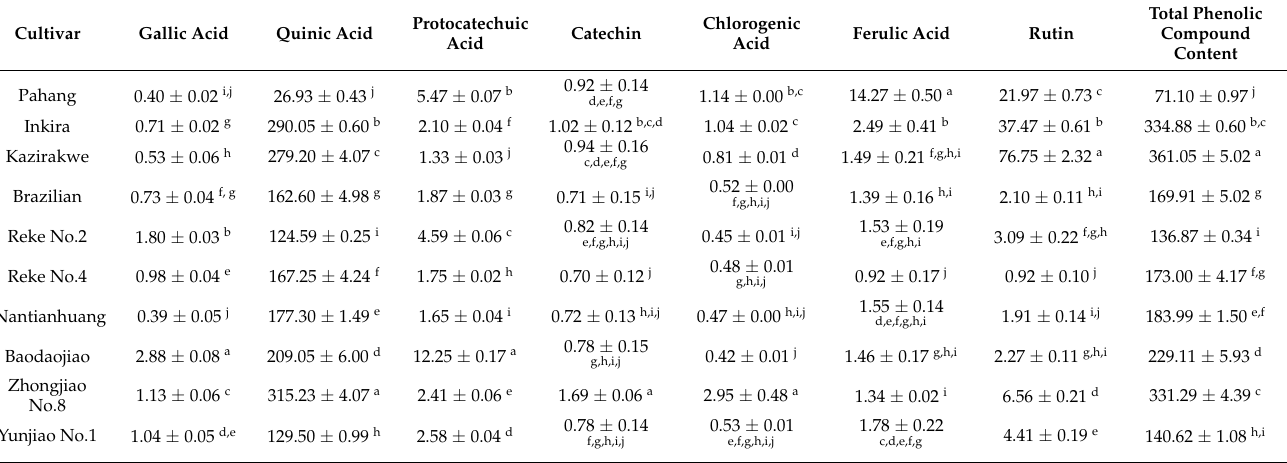
Statistical note: Means ( n = 3) within a column followed by different letters are significantly different at p < 0.05 according to the Tukey’s honestly significant difference (HSD) multiple range test. Means with superscripts having the same letter are not significantly different. Table 7. Determination of main phenolic compounds in ripe fruit peel of 10 banana cultivars ( µ